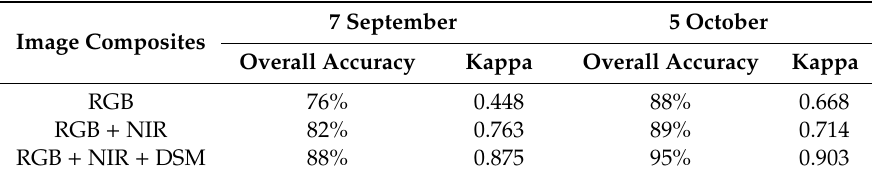
Table 3. Accuracy assessment results for three image composites at the Minxiong sampling site.